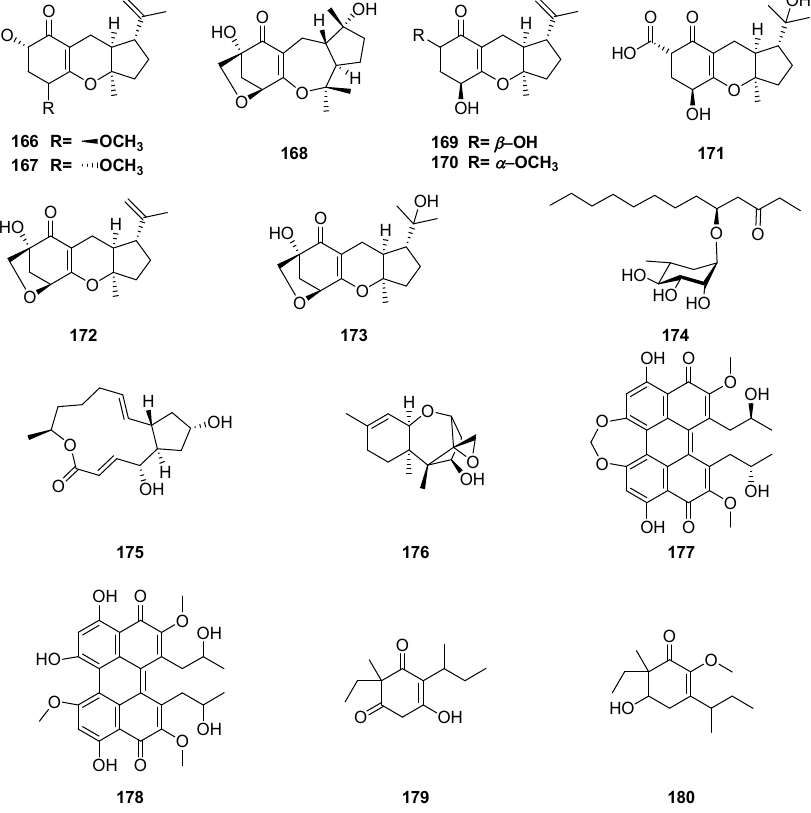
Figure 13. Compounds extracted from endophytic fungi, Guignardia sp and Mycosphaerella sp. obtained from Scyphiphora hydrophyllacea and Psychotria horizontalis, respectively .